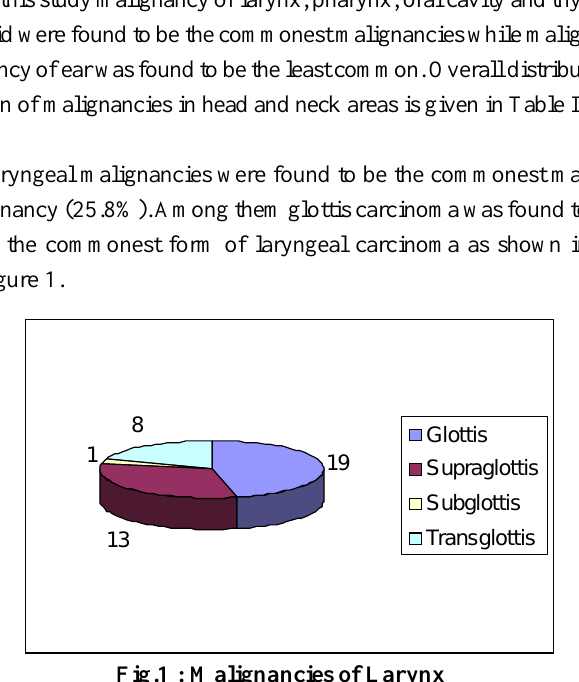
Fig.3 : TNM staging of head and neck